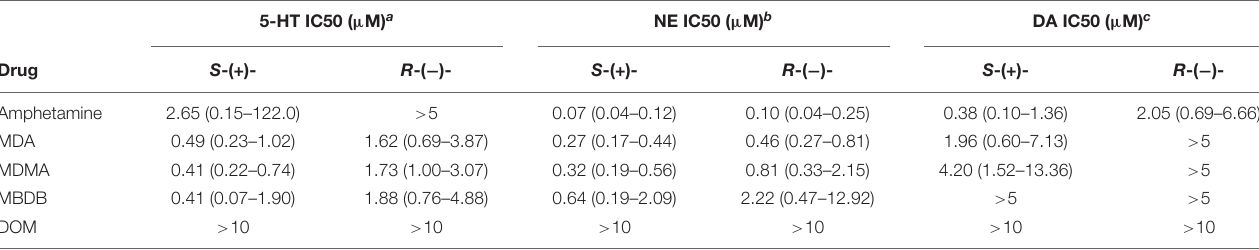
TABLE 1 | A summary of uptake inhibition by the enantiomers of amphetamine, MDA, MDMA, MBDB, and DOM at uptake sites for 5-HT, NE, and dopamine (DA) in rat brain synaptosomes (23).